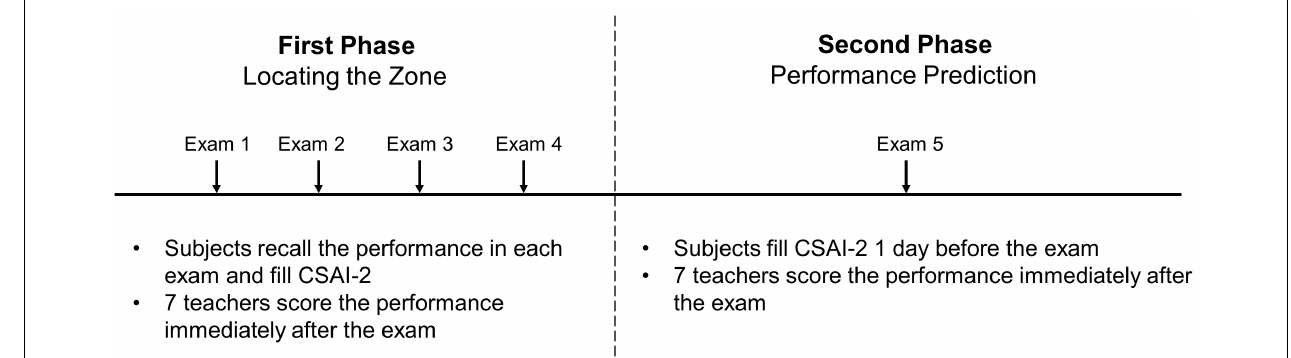
FIGURE 1 | The study protocol.